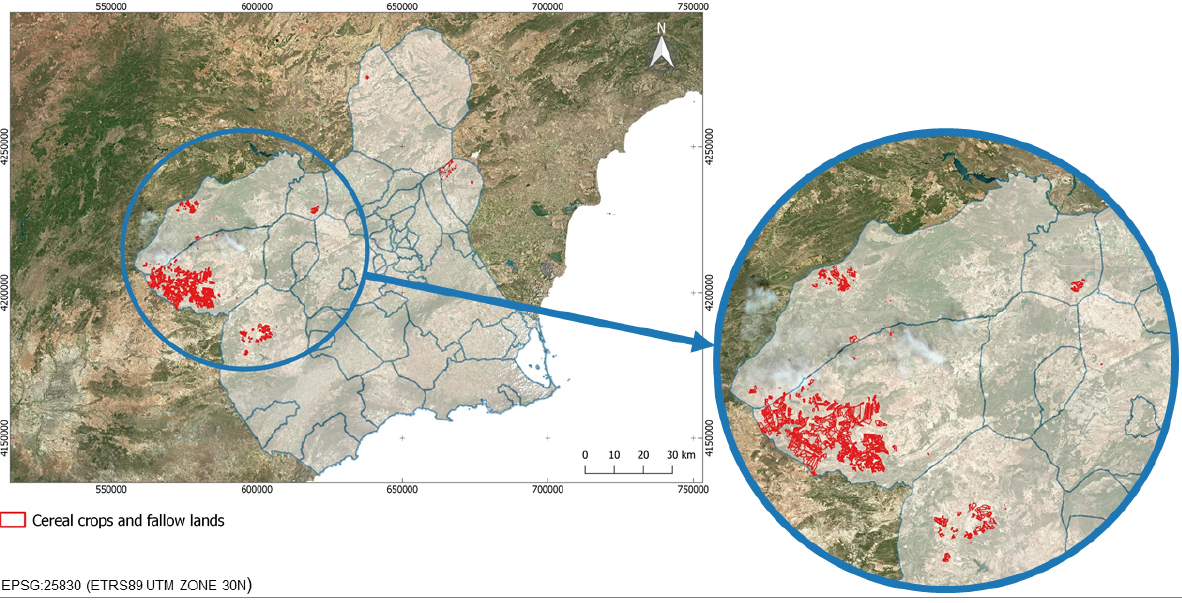
Figure 1. Study area in the Autonomous Community of the Region of